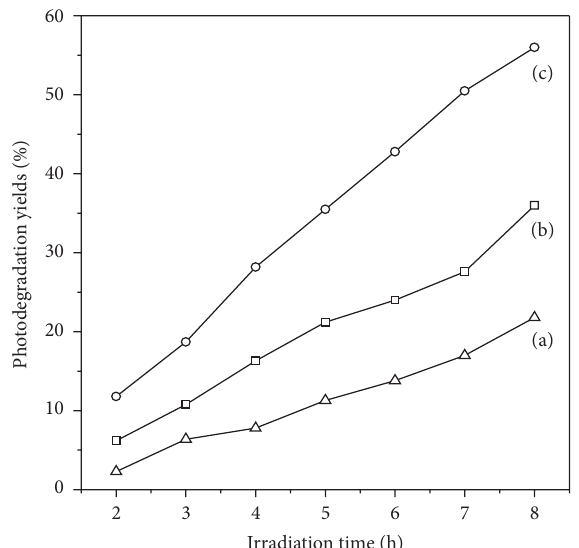
Figure 5: Photodegradation yields of methylthionine chloride (a), rhodamine B (b), and gentian violet (c) over MTiO 2 /RRP under visible- light irradiation ( 𝜆 > 420 nm).